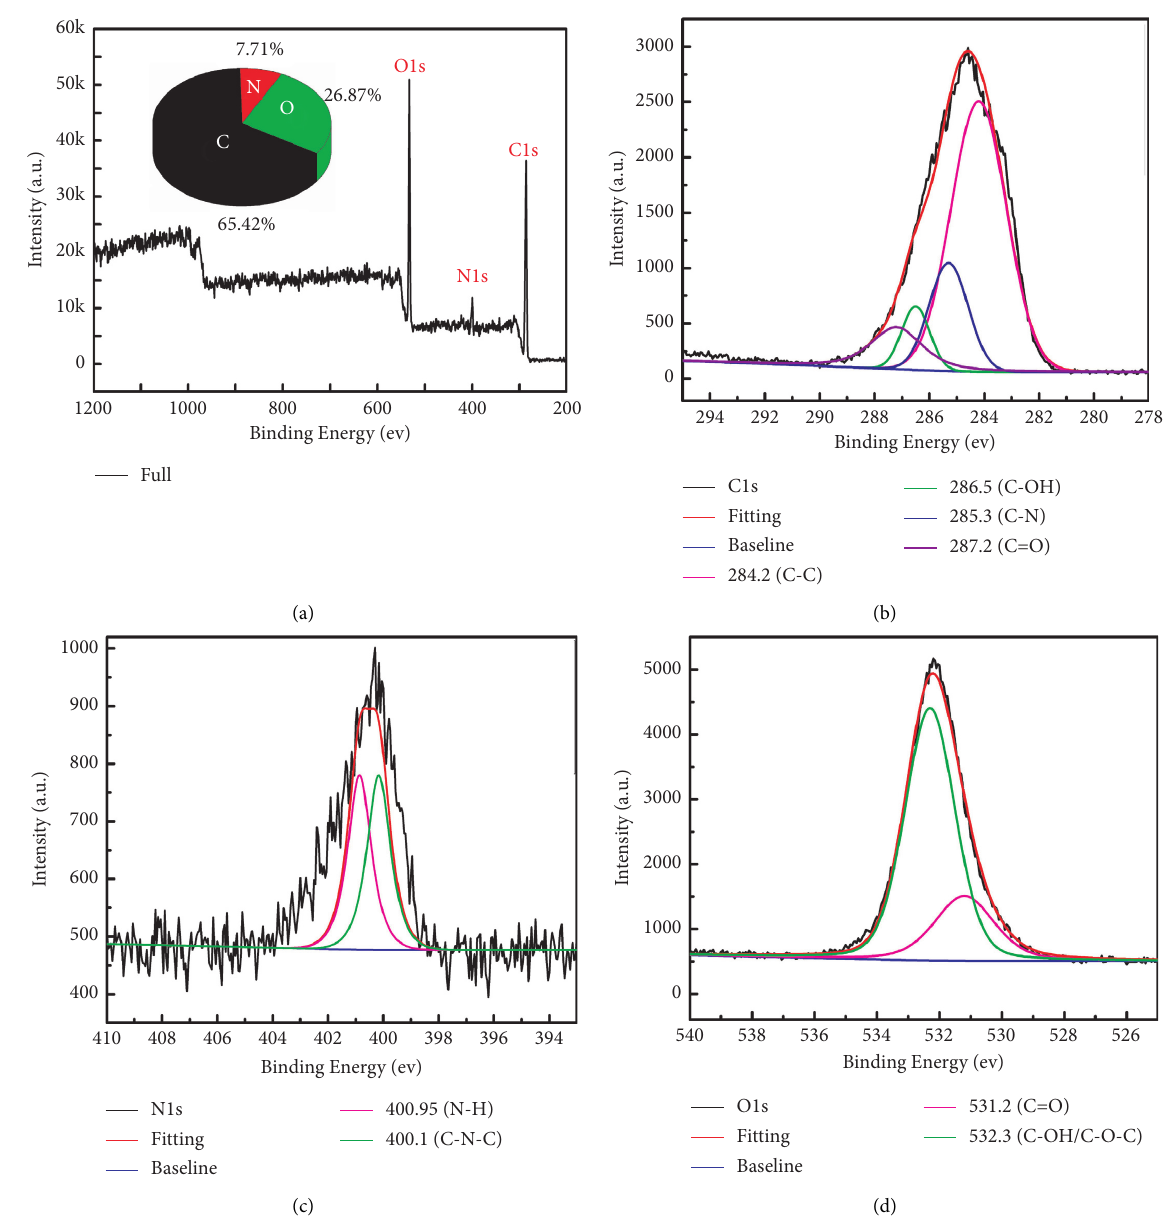
Figure 3: (a) XPS full spectrum of CQDs; (b–d): C1s, N1s, and O1s peaks of high-resolution XPS spectra,